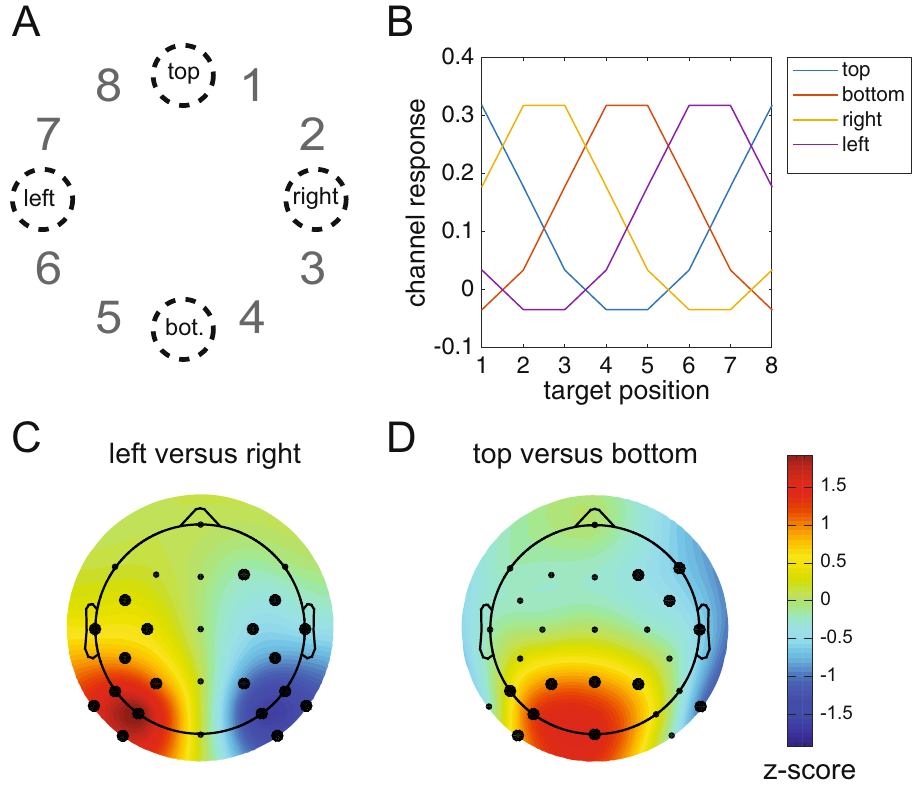
Figure 9. Reconstructing the neural signature of attentional capture for target positions that were never presented during Experiment 2. ( A ) The target positions that are reconstructed: top, bottom, left and right. ( B ) The constructed channel responses that are associated with these positions using the CTF from Fig. 8A (see methods for details). Top is in between target position 8 and 1, so the channel response to top is constructed by averaging the hypothetical channel response to position 8 and position 1. Similarly, right is created from averaging channel responses to 2 and 3 etc. Any position on the circle can be constructed using a weighted average of channel responses. Left, right, bottom and top weights were reconstructed using the product of the constructed channel responses and the weight matrix at 260–270 ms. Next, the left versus right pattern was generated by subtracting the left from the right pattern ( C ), likewise the top versus bottom pattern was created by subtracting the bottom pattern from the top pattern ( D ). Note the similarity with the left-right and top- bottom patterns from Experiment 1. All patterns were normalized across space to allow direct comparisons. Thick electrode dots belong to a cluster that has p < 0.01 under cluster based permutation